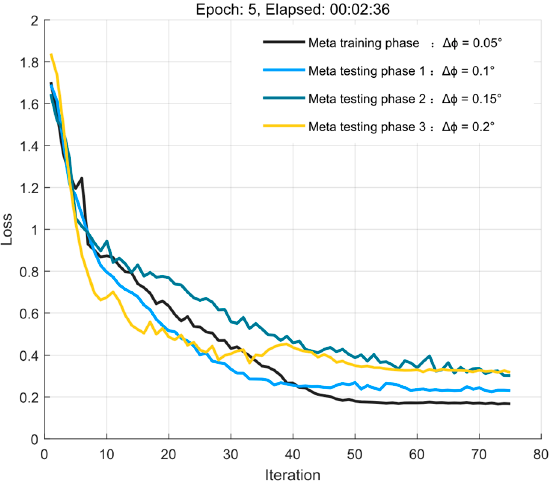
Figure 4. Loss convergence curve when taking different quantization.